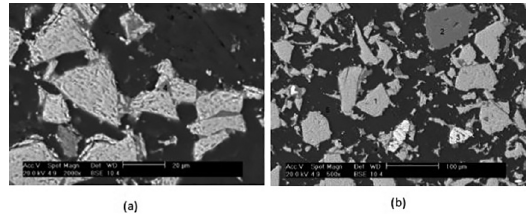
Figure 5: Backscattered electrons of the P7 pellet (4% sodium silicate) after 1573 K for 120 minutes (a) 500x, (b) 2000x.